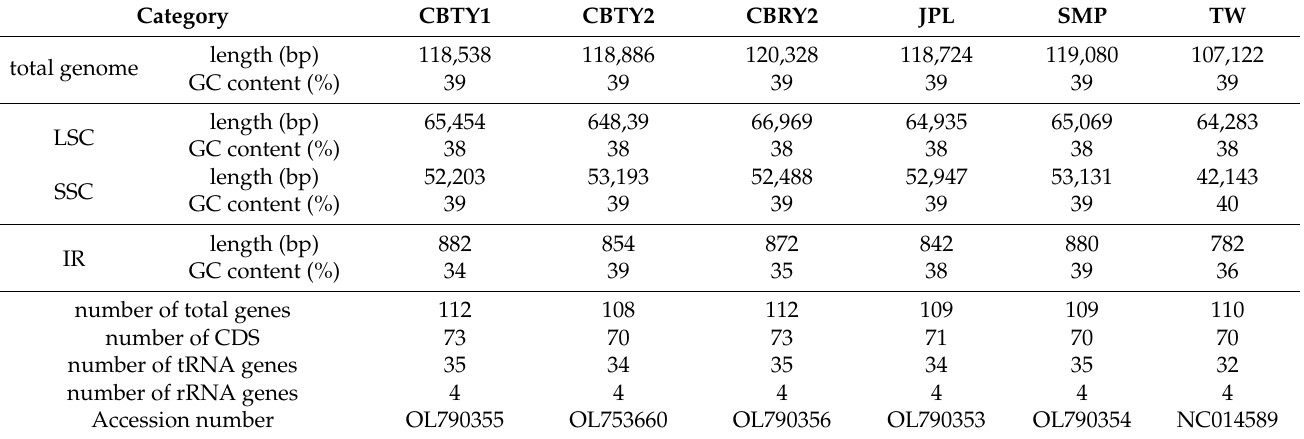
Table 1. Chloroplast genome features of Cathaya argyrophylla populations from six locations in China.